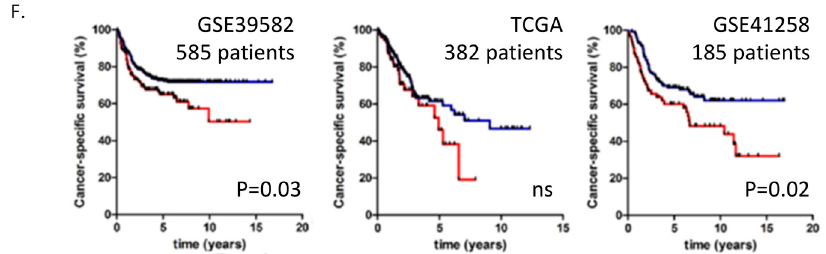
Figure 1. Laminin 511 is expressed by colon cancer cells in metastatic tumours and is associated with adverse outcomes in colorectal cancer. ( A ) Immunofluorescence staining for laminin (green) in orthotopic liver metastases developed using HT29, HCT116 or LoVo human colon cancer cell lines or in a human liver metastasis resection specimen. Counterstained with DAPI. M indicates metastasis and the white border demarcates the metastasis–liver interface. Scale bar represents 100 µ m. ( B ) Immunofluorescence staining of HT29 orthotopic liver metastasis stained for the indicated markers using non species-specific antibodies. Scale bar represents 30 µ m. ( C ) mRNA profile of all known laminin and collagen type IV chain genes in RNA extracted from orthotopic HT29 (green), HCT116 (blue) and LoVo (pink) liver metastases using human-specific primers. ( D ) Oncomine TM data demonstrating mRNA expression of LAMA5, LAMB1 and LAMC1 in colon cancer relative to normal colon from multiple independent GSE datasets. ( E ) Expression of the indicated laminin chains in normal colon, primary colon cancer, normal liver and liver metastases through analysis of data from GSE41258. Error bars are the SEMs compared with Students t -test. ( F ) Kaplan–Meier curves (Log-rank comparison) showing cancer-specific or absolute survival in data generated from publicly available gene array datasets. Patient groups are defined by over-expression of LAMA5, LAMB1 and LAMC1 (red) or normal expression of these genes (blue). * 0.01 < p ≤ 0.05, *** p ≤ 0.001.